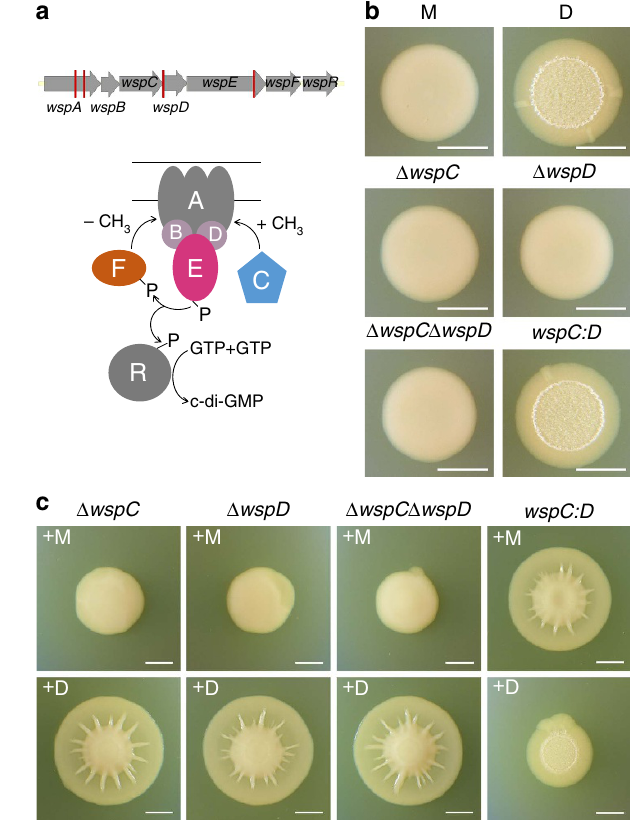
Figure 6 | Genetic analyses of the D morphotypes and the spreading phenotype. ( a ) Schematic of the wsp operon (top). Red vertical bars indicate the site of individual mutations found among the D morphotypes. A simplified model of the corresponding Wsp signalling system modulating c-di-GMP production (bottom). ( b ) Genetic analysis suggests that the original D strain has a mutation that hybridizes the WspC and WspD proteins. Comparison of the colony morphology of the engineered strains to M and D on day 3. Only the wspC:D hybrid mutant (that is, the same mutation found in D) exhibits the same dry morphology as D. ( c ) Comparison of the spreading phenotype of the engineered strains mixed at a 1:1 ratio with either M or D on day 8. Scale bars,